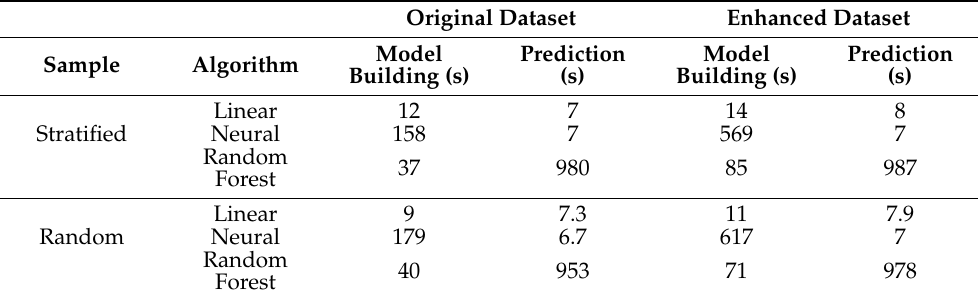
Table 6. Model building and prediction times (in seconds) of different algorithms on both the original and enhanced